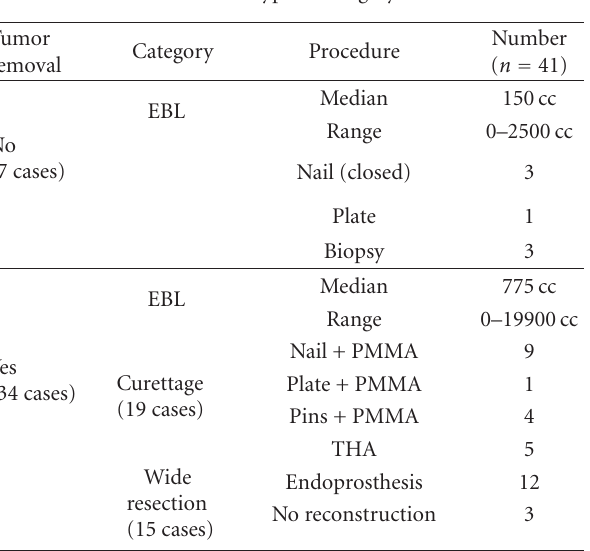
Table 2: Types of